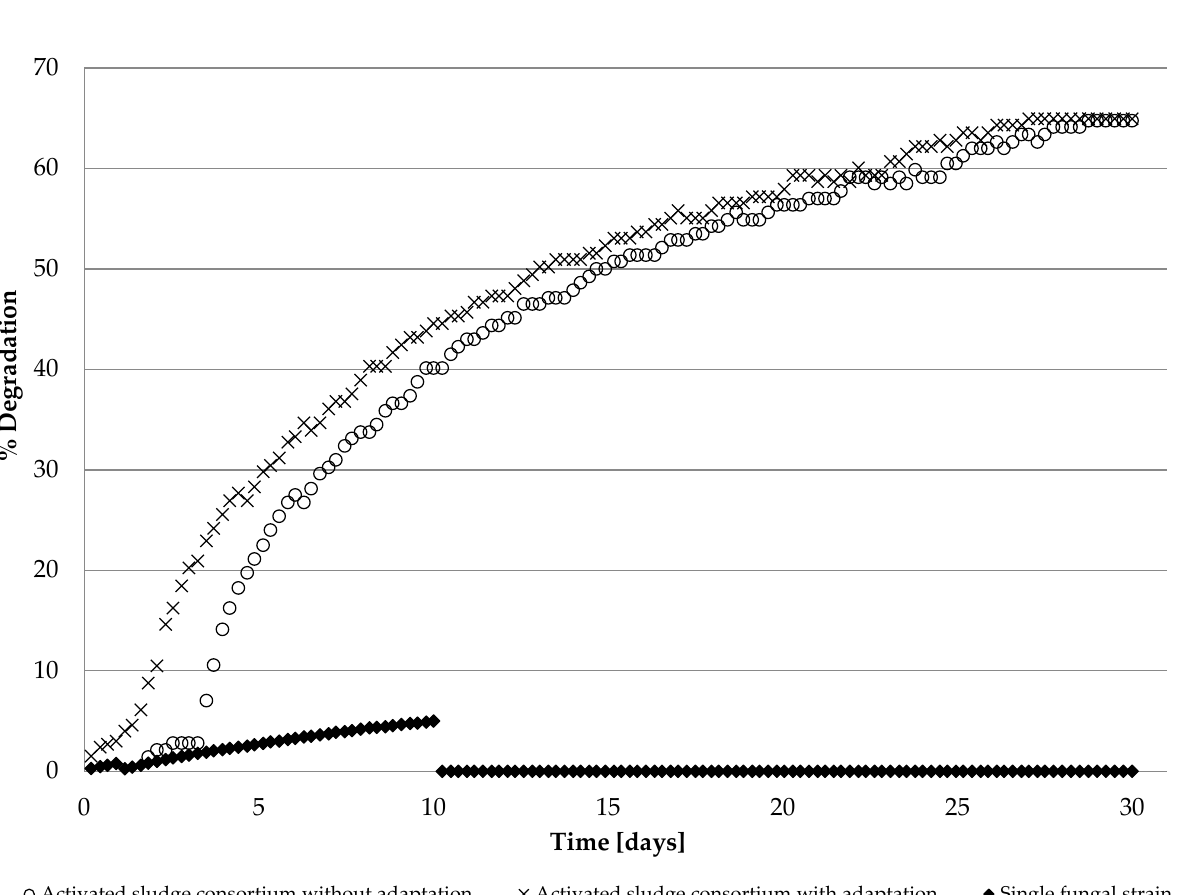
Figure 2. % Degradation test of [OMIM][Cl] by a single fungal strain Candida tropicalis (diamonds) and community of microorganisms in the form of activated sludge and fungal strain before (circles) and after (crosses) adaptation to the presence of IL.